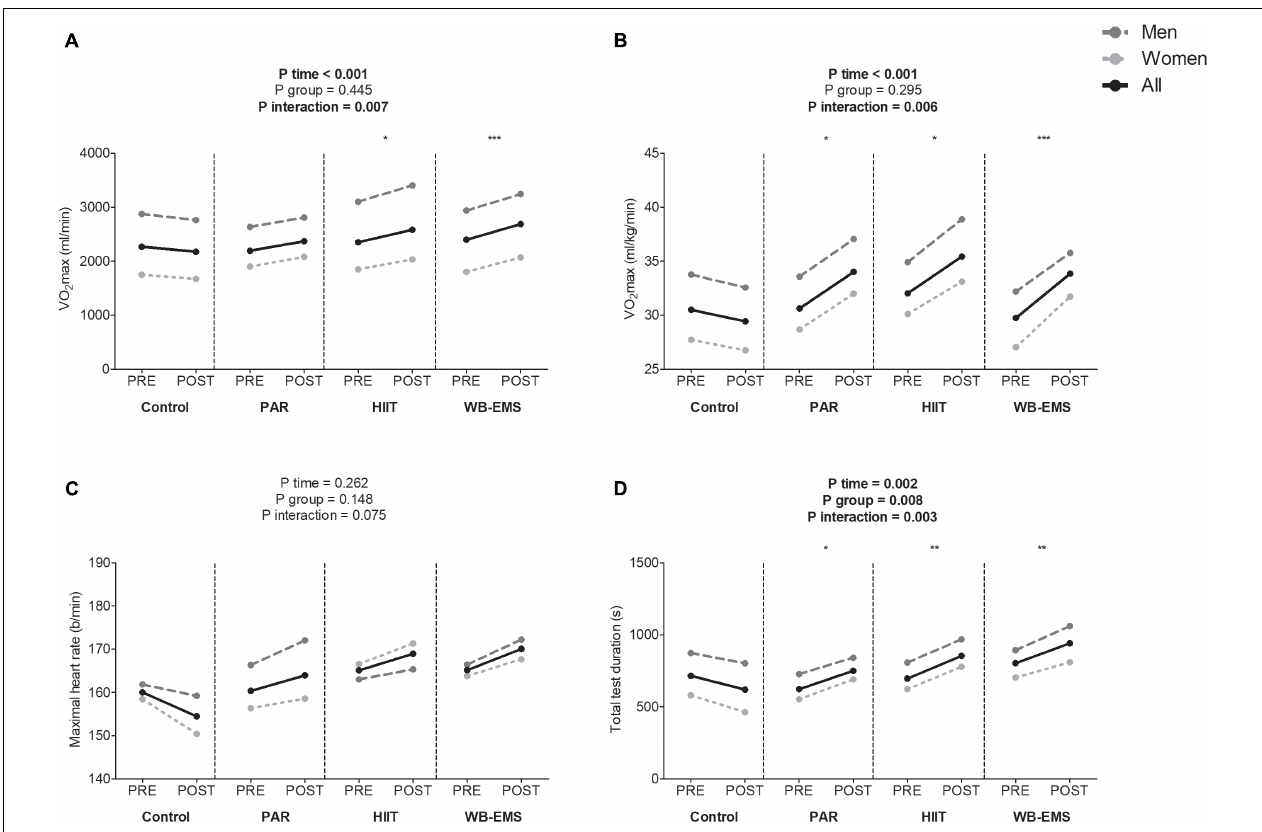
FIGURE 2 | Changes in maximum oxygen uptake (VO 2 max) in absolute (A) and relative terms (B) , maximal heart rate (C) , and total test duration (D) values before and after the intervention study. P -value [time, group, and interaction (time ∗ group)] of repeated measures analysis of variance. ∗ P < 0.05, ∗∗ P < 0.01, ∗∗∗ P < 0.001 obtained by Student’s paired t -test. PAR, physical activity recommendations for adults proposed by the World Health Organization group; HIIT, high intensity interval training group; WB-EMS, whole-body electromyostimulation